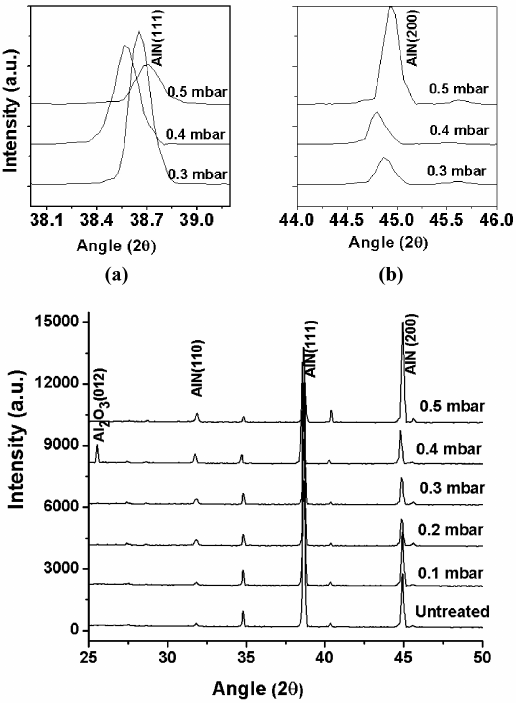
Figure 1. XRD spectra of Al samples nitrided at various filling pressures (0.1, 0.2, 0.3, 0.4 and 0.5 mbar) and fixed treatment time of 5 hours. Insets (a) and (b) resolve AlN(111) and (200)